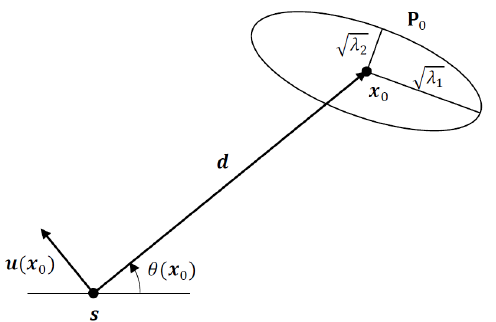
Figure 1. The 2D AOA geometry and 1- σ error ellipse for Gaussian prior with mean x 0 and covari- ance P 0